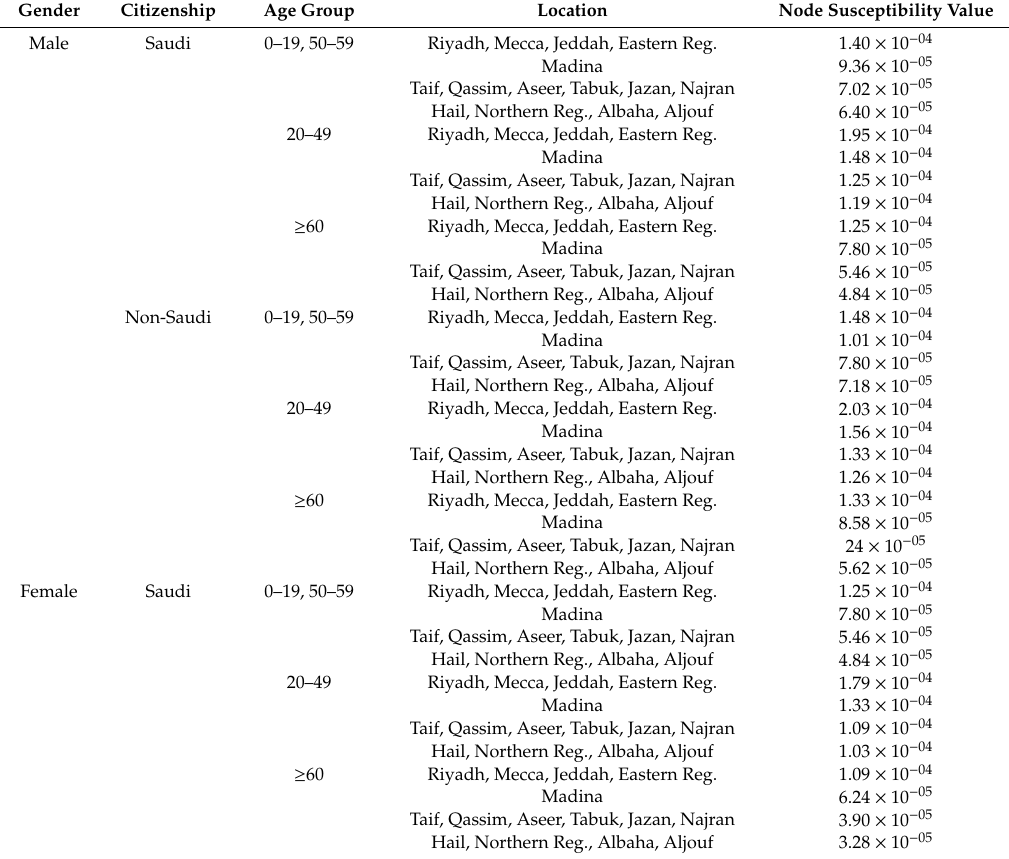
Figure A3. Node susceptibilities based on age group, gender, citizenship, and location. Blue markers represent male nodes and red markers represent female nodes. Marker borders denote citizenship (gray represent Saudi and yellow represent Non-Saudi). Marker shapes denotes the different location as follows. Circles represent Riyadh, Mecca, Jeddah, and the Eastern region. Squares represent Madina. Diamonds represent Taif, Qassim, Aseer, Tabuk, Jazan, and Najran. Triangles represent Hail, Northern region, Albaha, and Aljouf. Table A3. Simulation model parameters: node susceptibilities based on attributes.